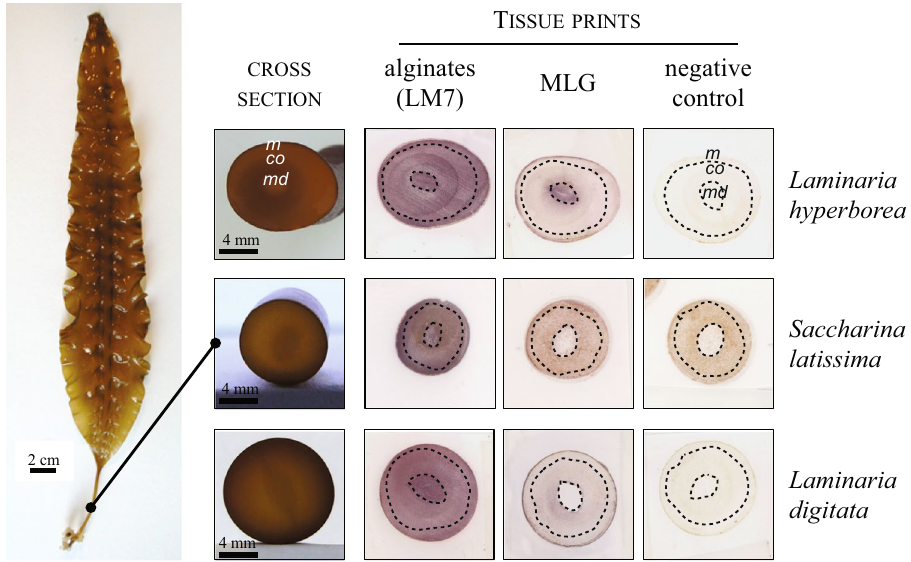
Figure 4. Detection of MLG in stipes from Laminariales by tissue printing. The tissue prints of stipes from Laminariales were probed by the anti-mixed linkage glucan (MLG) and anti-alginates (LM7) antibodies. The samples being naturally pigmented, negative controls are included to appreciate the signal due to the antibody binding. Corresponding cross sections of the stipes are shown on the side. A representative picture of a whole plant of Saccharina latissima is indicated for size indication. The LM7 epitopes are abundant in all tissues. MLG is of a more restricted occurrence and shows distinct spatial localization depending on the alga. It is mostly detected in the medulla for Laminaria hyperborea , while it is more largely distributed in the meristoderm and the cortex in S . latissima . m, meristoderm; co, cortex; md, medulla. The dot lines broadly indicate the different regions in tissues as observed by light